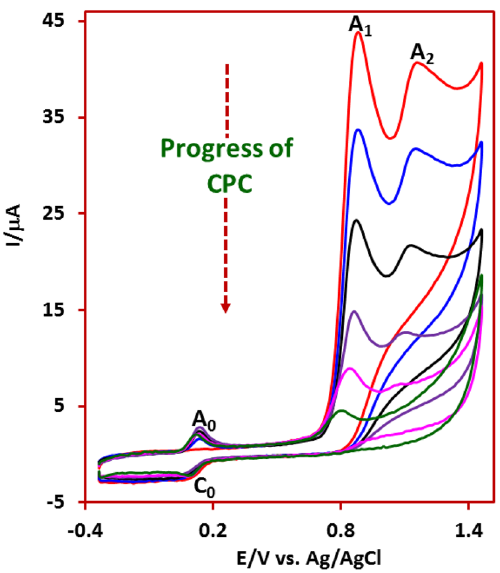
Figure 3. Cyclic voltammograms of IMP (0.25 mmol) during controlled-potential coulometry at + 0.85 V versus Ag/AgCl in water (acetate buffer, c = 0.2 M, pH 5.0). Scan rate: 50 mV s −1 , at room temperature.